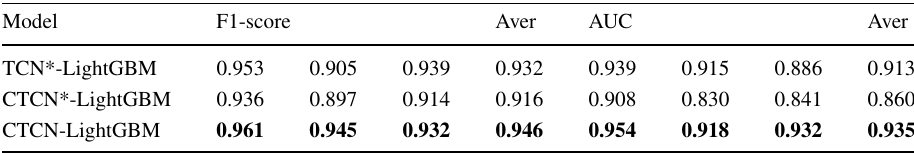
The bold values indicate superior metric values of the proposed